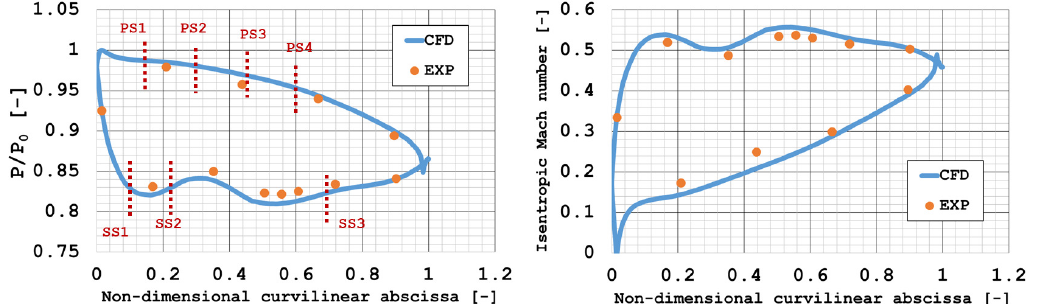
Figure 4. Vane pressure and Mach number